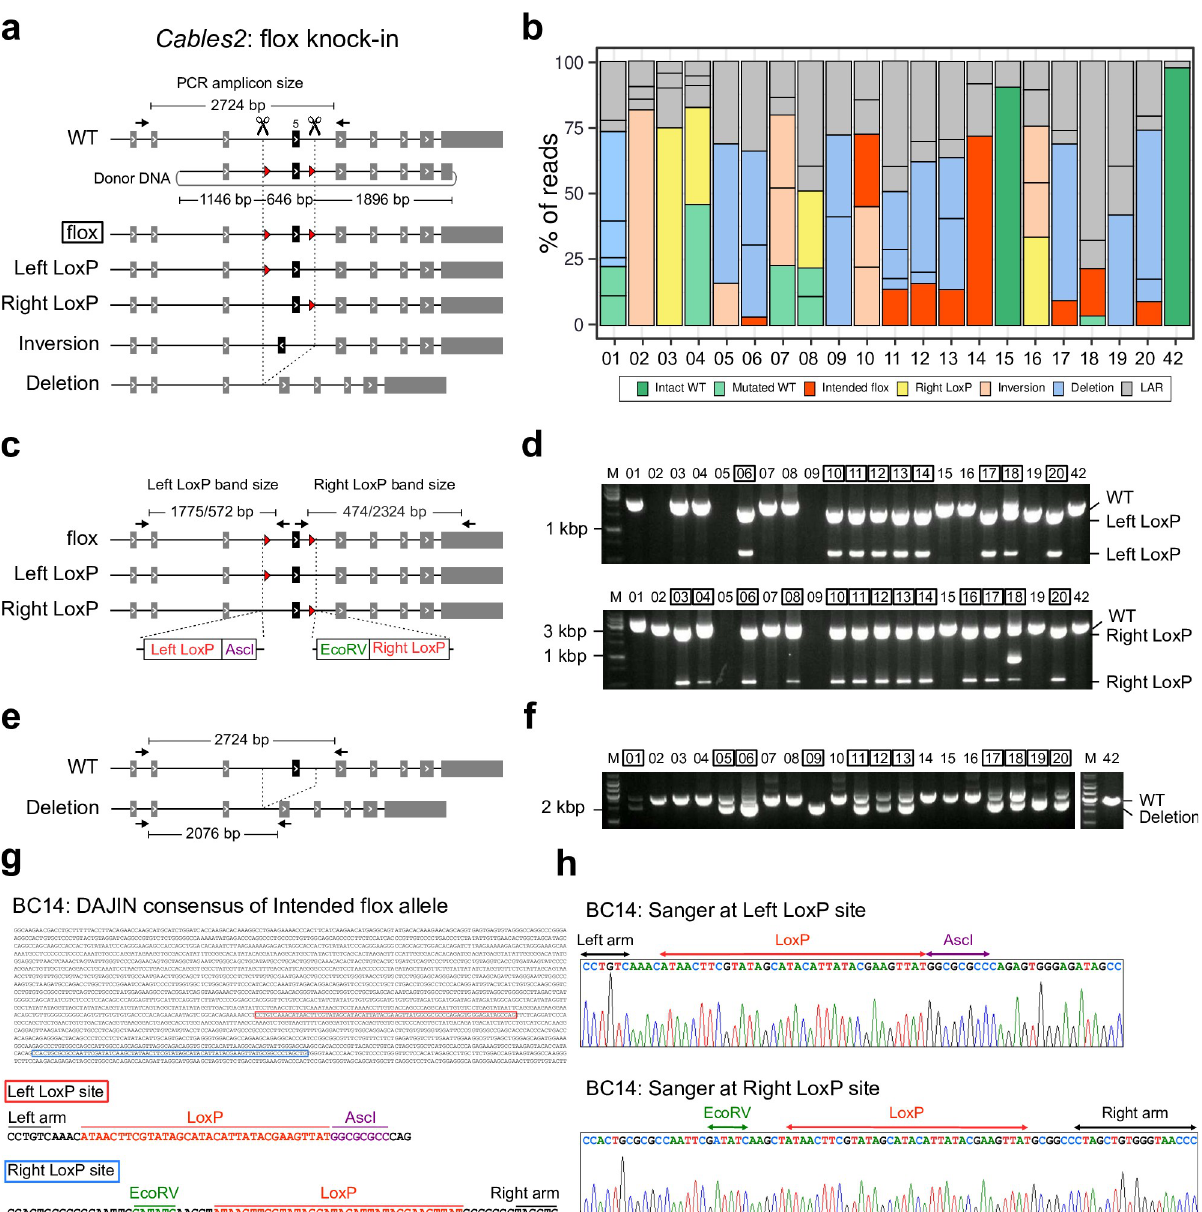
Fig 6. Application of DAJIN for flox KI design. (a) Genome editing design for flox KI into the Cables2 locus. The scissors represent Cas9-cutting sites. The arrows represent PCR primers, including the size of the PCR amplicon. The circular DNA represents the donor DNA. The base numbers on the donor DNA describe the left, central, and right arm sizes. The red arrowheads represent LoxPs. The boxed allele type represents the target allele. The other allele types include Left LoxP and Right LoxP. Inversion and Deletion represent possible by-products. (b) DAJIN’s report of the allele percentage. The barcode numbers on the x-axis represent mouse IDs. BC42 is a WT control. The y-axis represents the percentage of DAJIN-reported alleles. The colours of the bar represent DAJIN-reported allele types. The compartments partitioned off by horizontal lines in a bar represent the DAJIN-reported alleles. (c) Design of PCR-RFLP to validate LoxP KI alleles. The AscI and EcoRV restriction sites are adjacent to Left LoxP and Right LoxP, respectively. The arrows represent PCR primers for the digested DNA fragments, including PCR product sizes. (d) PCR results for the detection of the LoxP KI allele. The top and bottom panels represent DNA fragments digested with AscI and EcoRV, respectively. The numbers on the panel mean barcode IDs. The boxed number represents the samples with LoxP alleles. (e) Design of PCR to validate deletion alleles. The arrows represent PCR primers. (f) PCR results for the detection of deletion alleles. The panels show the PCR products. The number on the panel means barcode IDs. The boxed number represents the samples with deletion alleles. (g) DAJIN’s consensus sequence of the floxed allele in BC14. The red and blue boxes represent left and right LoxP sites, respectively. (h) Sanger sequences for the LoxP sites. See S6 Data for raw data from https://osf.io/w7ade/. DAJIN, Determine Allele mutations and Judge Intended genotype by Nanopore sequencer; KI, knock-in; LAR, large rearrangement; WT, wild type.